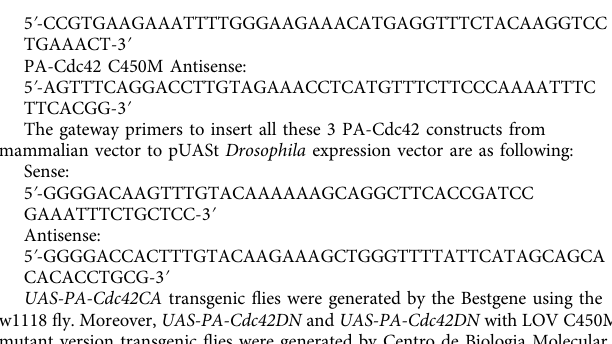
Fig. 6 Cortical tension anisotropy is under the control of Cdc42. a – d Time-lapse series of a representative cell not expressing ( a , b ) and expressing ( c , d ) the Cdc42DN transgene marked by mCD8GFP coexpression, before (panel on the left) and after ablation (indicated by the dashed line) of the basal actomyosin network along the AP ( a , c ) and the DV ( b , d ) axes. MyoII is visualized by using a MyoII-mCherry construct. Right panel: kymographs illustrating network recoil along the DV ( a , c ) and the AP ( b , d ) axes after ablation. The results shown in a – d have been successfully repeated from the at least four independent experiments. e Maximum recoil speed after ablations in the n individual control (only mCD8GFP expressing) and Cdc42DN clones. For the control DV vs. AP comparison: p < 0.0001; for the Cdc42DN DV vs. AP comparison: p = 0.0788; both by two-sided Mann – Whitney test. f , g Time- lapse series of a representative wild-type cell, neighboring ( f ) or distantly located ( g ) from Cdc42DN-expressing clones, before and after ablation (indicated by the dashed line) of the actomyosin network along the AP axis. Right panel: kymographs illustrating network recoil after ablation. The results shown in f , g have been successfully repeated from the at least four independent experiments. h Maximum recoil speed after ablations in the n individual wild-type cells that are neighboring or distantly located from Cdc42DN-expressing clones. p < 0.0001 by two-sided Mann – Whitney test. Data are presented as mean values + / − SEM. Scale bars are 5 μ m in a , b , c , d , f , g